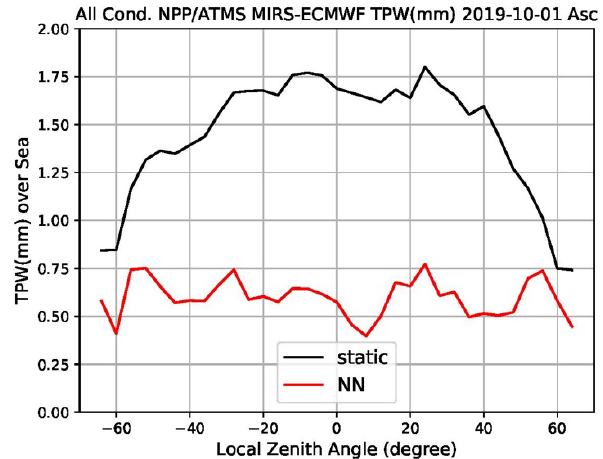
Figure 8. MiRS total precipitable water (mm) local zenith angle dependence of SNPP / ATMS on 1 October 2019 over ocean, ascending node. The black line is the result using a static bias correction and red line is the result using the NN bias correction.